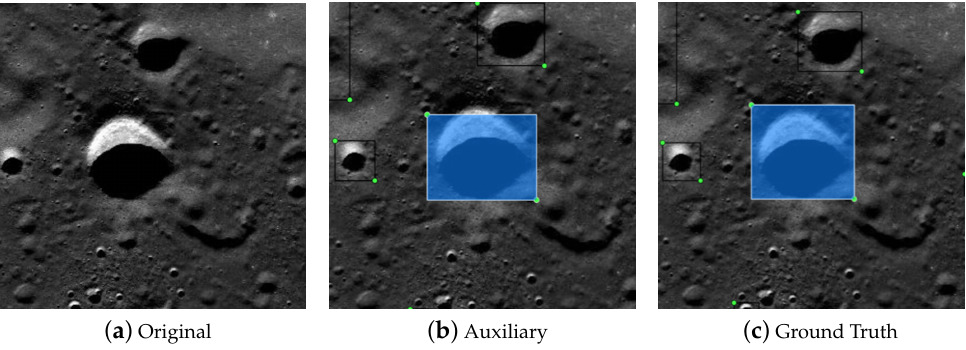
Figure 8. Visualization of a Moon image under different processing processes: ( a ) the input picture; ( b ) the pre-labeled picture using the auxiliary network; ( c ) the manually fine-tuned